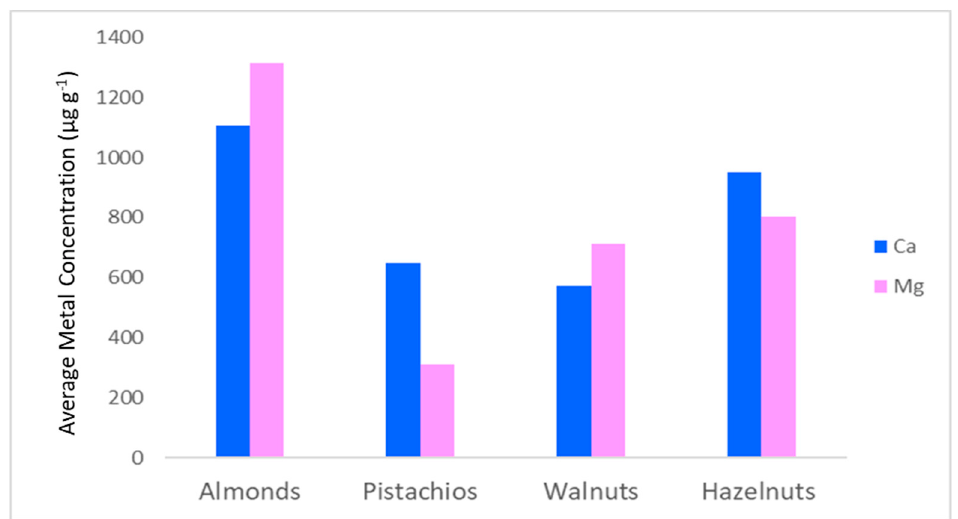
Figure 9. Average content of Ca and Mg among almonds, pistachios, walnuts and hazelnuts available in a Greek market.